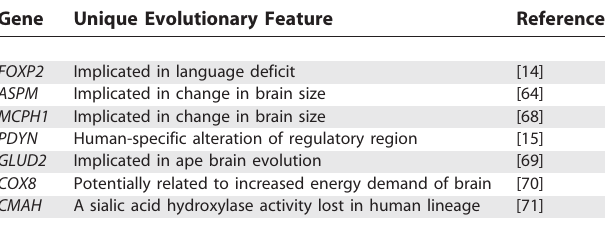
Table 1. Single-Gene Studies Potentially Related to the Evolution of Human Cognitive